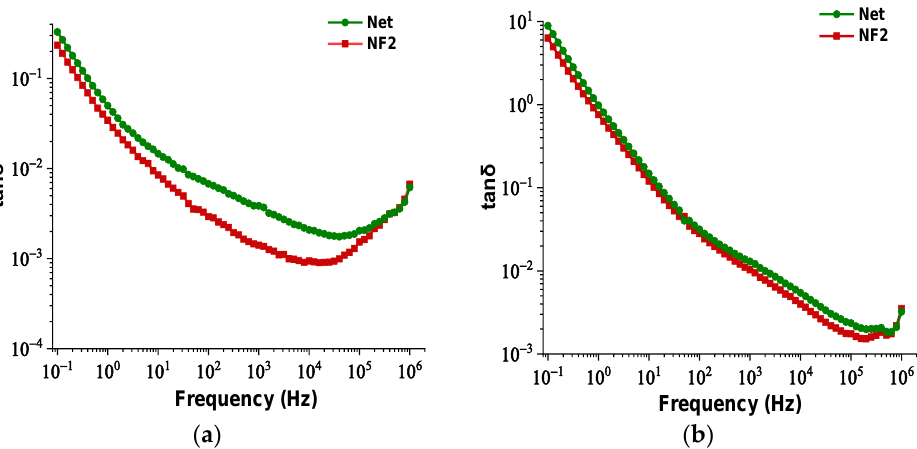
Figure 11. Change in dielectric dissipation factor versus frequency of the Net and NF2 samples: ( a ) at 25°C and ( b ) at 90 °C.